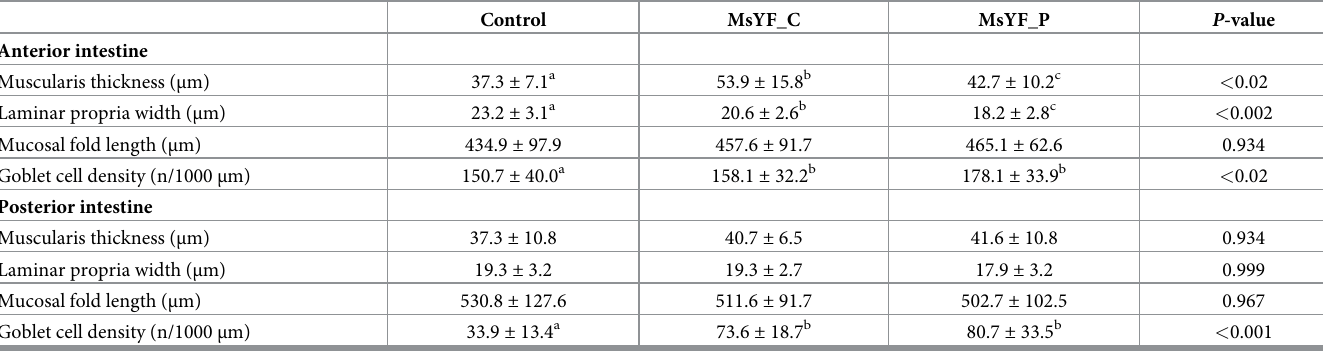
Table 4. Morphometric data from anterior and posterior intestine of rainbow trout fed experimental diets for 8 weeks. Control MsYF_C MsYF_P P